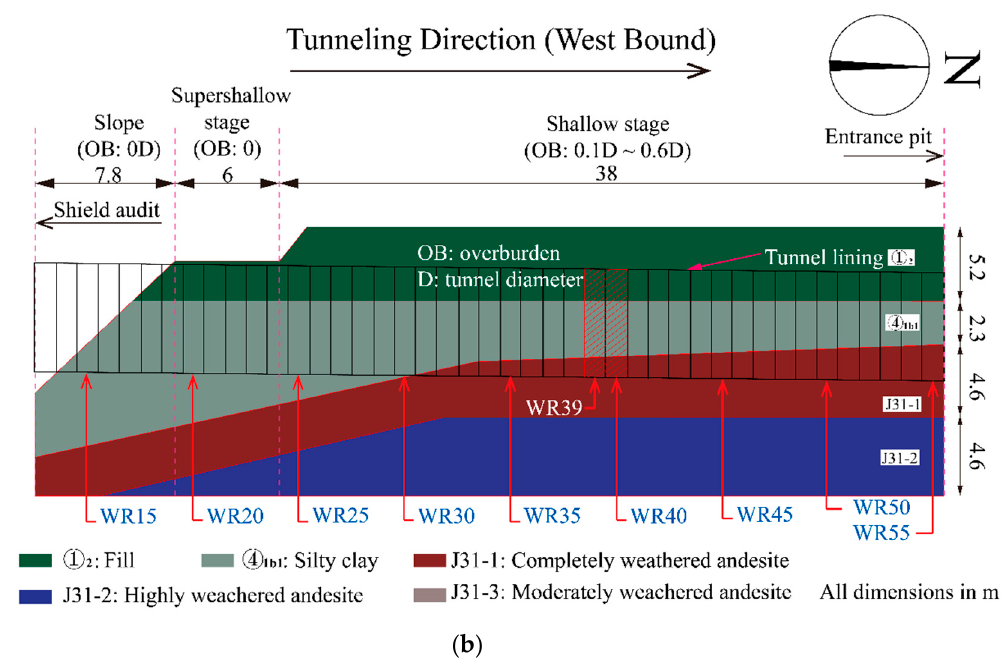
Figure 2. Geological profile of the ultra-rapid underground pass (URUP) tunnel: ( a ) tunnel of east bound; and ( b ) tunnel of west bound (redrawn after [34]).